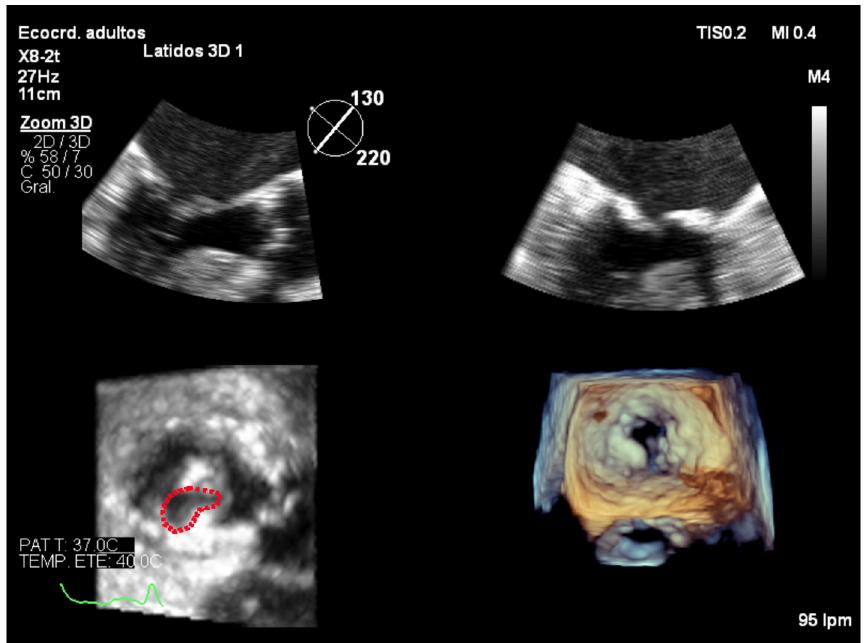
Figure 8. Zoom 3D focused on the mitral valve from the mid-esophageal four chamber view. Multiplanar reconstruction to perform 3D planimetry.